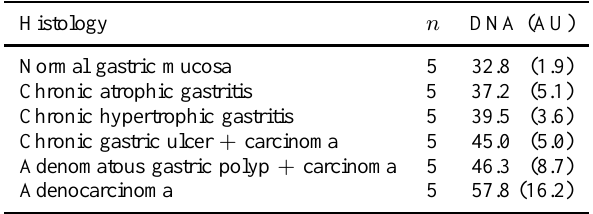
Table 1 Nuclear DNA contents (arbitrary units). Means and